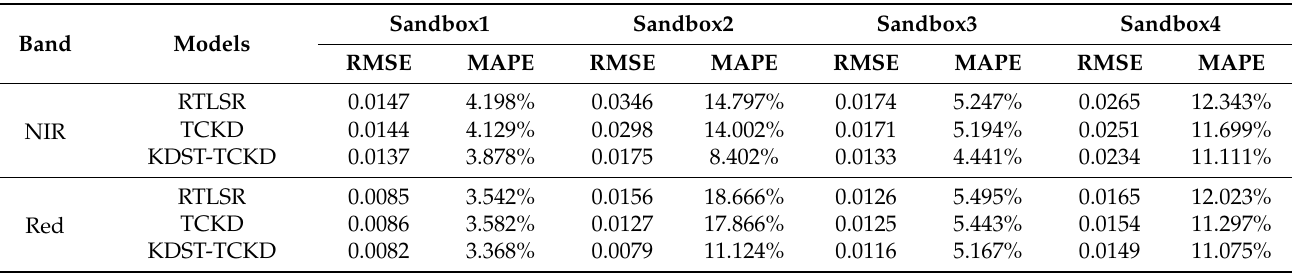
Figure 9. Comparison of performance of RTLSR model, TCKD model and KDST-TCKD model in red and NIR band over four different sandboxes. The width of the violin plot represents the frequency of the RMSE distribution. Columns from left to right are the four rugged terrains (Sandbox1: α = 8.4°, normal distribution; Sandbox2: α = 24.7°, normal distribution; Sandbox3: α = 25.7°, concave valley; Sandbox4: α = 30.36°, convex ridge). The first row are results for NIR band, and the second for red band. Table 2. Accuracy statistics of RTLSR model, TCKD model and KDST model in the red and NIR bands over four different sandboxes.